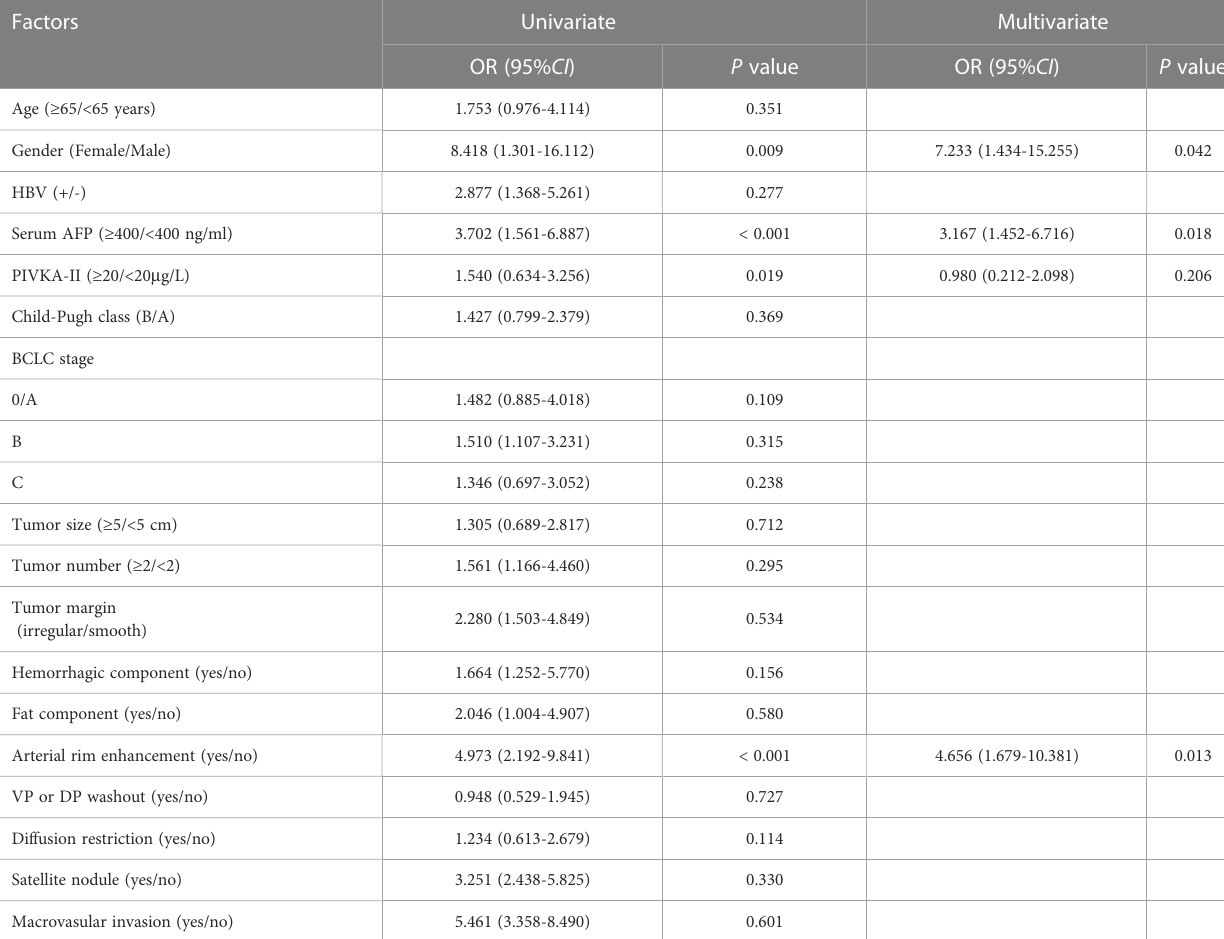
TABLE 4 Univariate and Multivariate analysis logistic regression of variables in predicting CK19